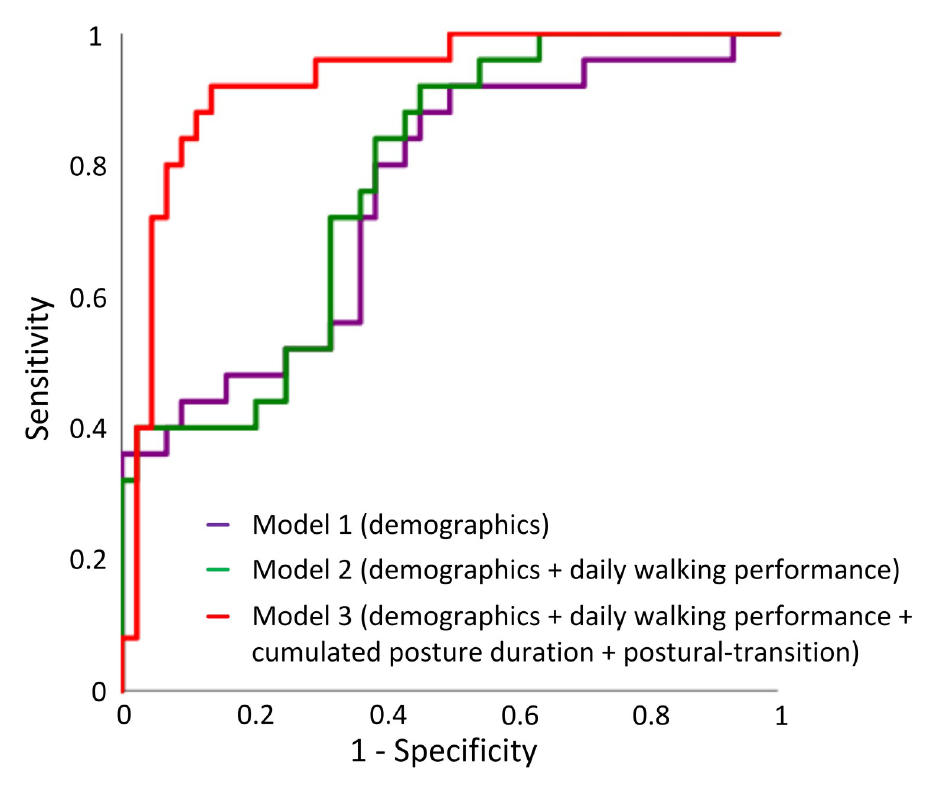
Fig 5. ROCs of different models for predicting cognitive impairment: Model 1 used “demographics” (AUC = 0.76), Model 2 used a combination of “demographics” and “daily walking performance” (AUC = 0.78), and Model 3 used a combination of “demographics”, “daily walking performance”, “cumulate posture duration”, and “postural-transition” (AUC = 0.93).